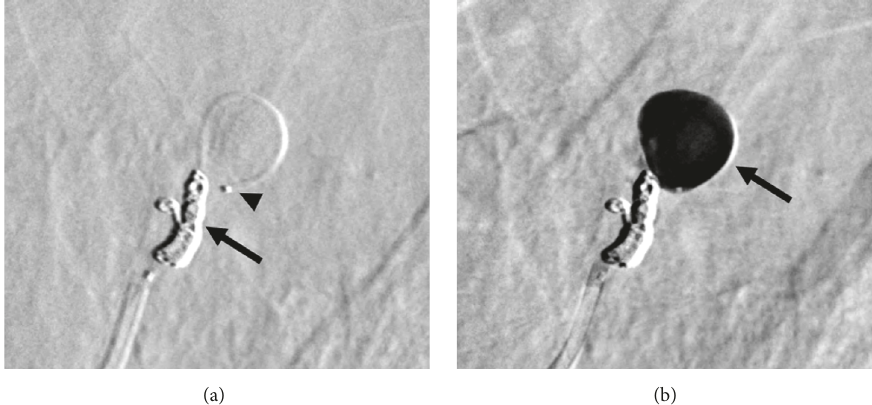
Figure5: Embolization oftheaneurysm. (a) Two microcatheters areplaced intheaneurysmand pulmonary artery proximal totheaneurysm. One microcatheter is used for proximal segmental pulmonary artery coil blocking proximal to the aneurysm (arrow); the other microcatheter is positioned into the aneurysm (arrowhead) before injecting a mixture of NBCA and iodized oil. (b) Complete filling of the aneurysm with the mixture of NBCA and iodized oil (arrow) is performed using the other microcatheter. NBCA, n-butyl-2-cyanoacrylate.